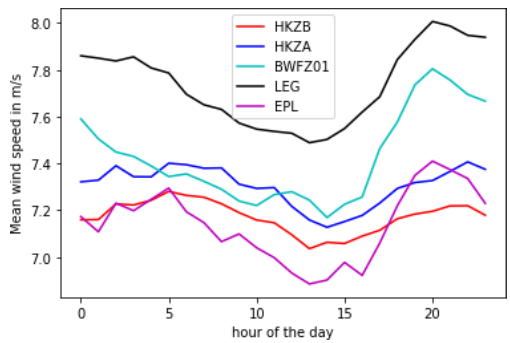
Figure 3. Intraday variability in mean wind speed at 120m for each lidar. The time is given in UTC, which is close to local time since Zone 1 and Zone 2 are located near the Greenwich meridian (the LEG curve is higher because the campaign was performed during winter).